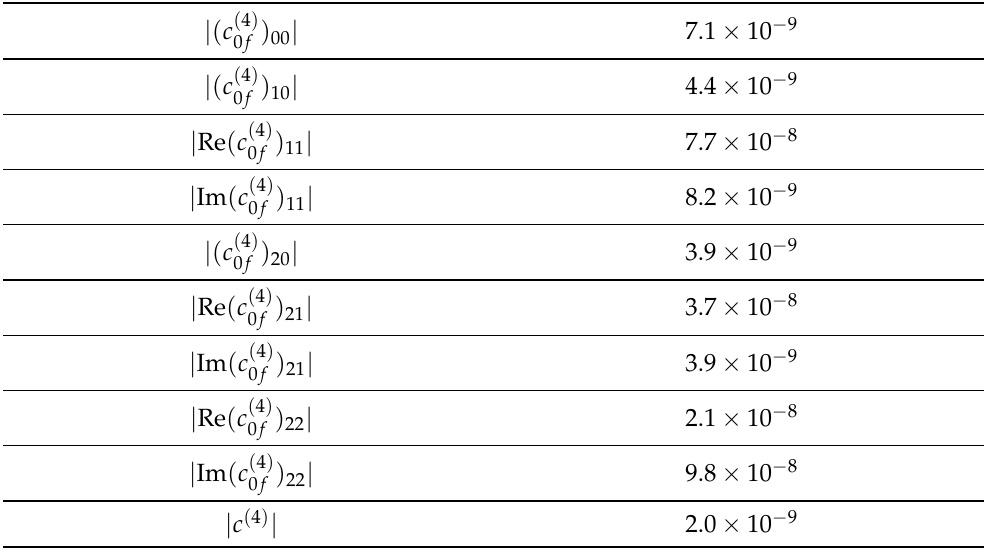
Table 2. Neutrino upper bounds on LIV from SN1987A for SME with dimension four operators. Data from